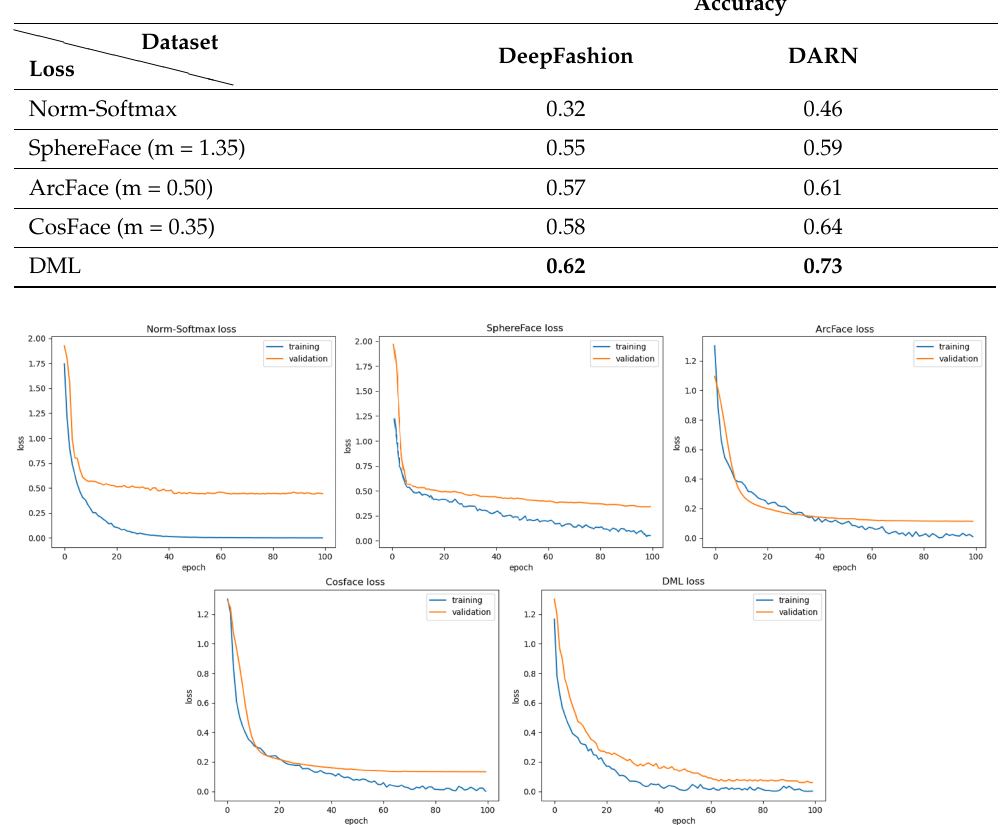
Figure 7. Training and validation losses for various margin-based Softmax loss functions using VGG16 network discussed in Section 4.2 for the consumer-to-shop clothes retrieval benchmark of the DeepFashion dataset. These results indicate that using DML for training leads to lower training loss than all other margin-based Softmax losses for consumer-to-shop clothes